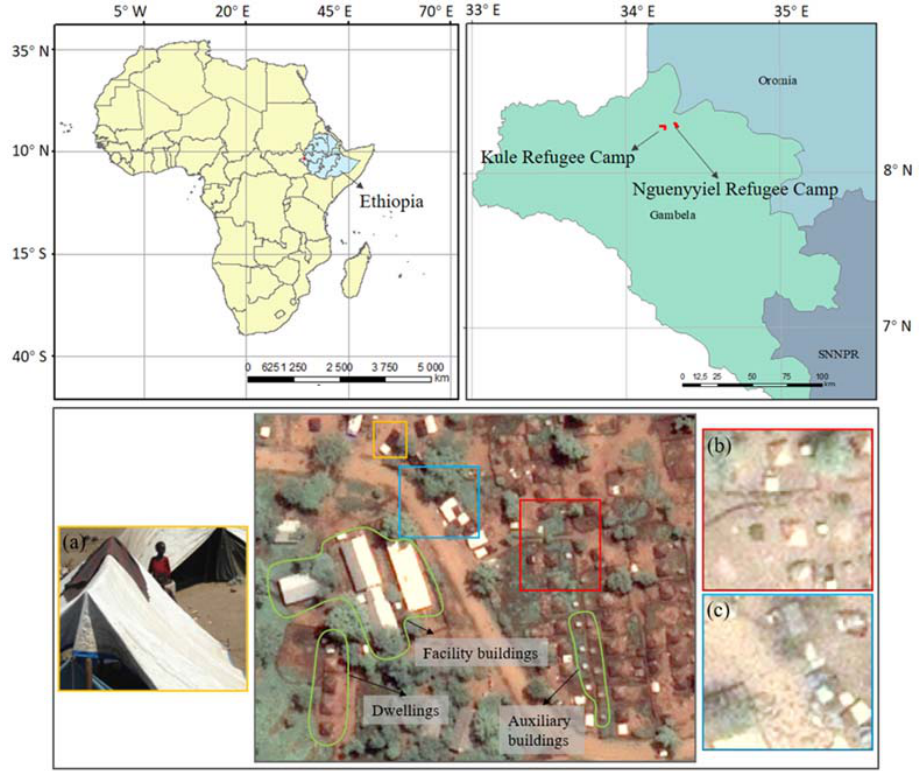
Figure 2. The location of Kule and Nguenyyiel refugee camps together with their typical roof ontology of built ‐ up structures. The subfigure ( a ) is the photo provided by MSF to reveal ground situations. The satellite imagery in the middle was retrieved from the wet season (22 June 2018), while ( b , c ) were retrieved from the dry season (24 March 2017). Yellow boundary: an example showing residents putting a brown cloth on the top of refugee tents. Red boundary: an example showing the dwelling roof turned from bright ‐ colored to brownish due to rusting and/or sand. Green boundary: examples of three types of built ‐ up structures. Blue boundary: an example showing trees can occlude built ‐ up structures in satellite imagery.